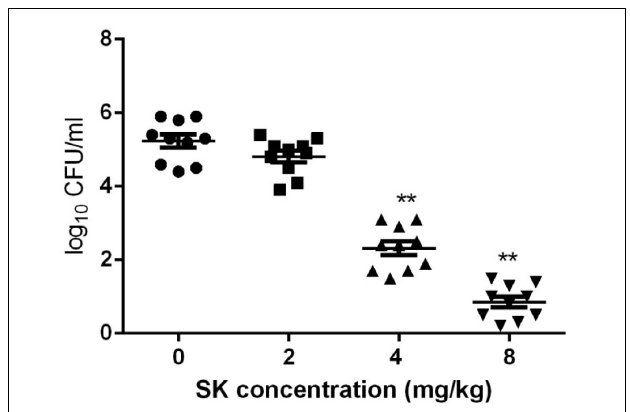
FIGURE 6 | Fungal burden analyses by colony counting after the administrations of SK in a mouse vaginal model. Statistical significance among the groups was analyzed by one-way ANOVA. ∗∗ P < 0.01 as compared to the values from the SK-free